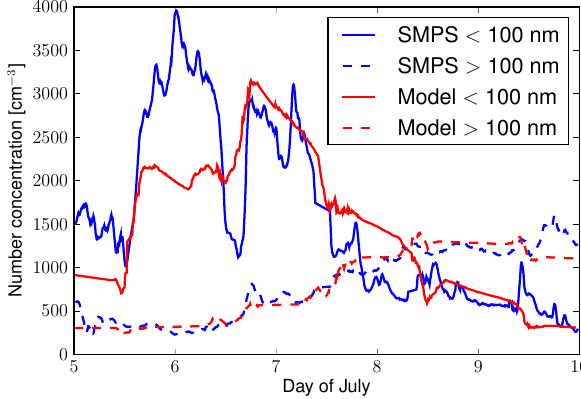
Fig. 9. Modeled and measured (Raven’s Nest) total particles with 16nm <D p < 100nm and total particles with D p > 100nm vs. time. 16nm is the lower size cutoff of the SMPS at Raven’s